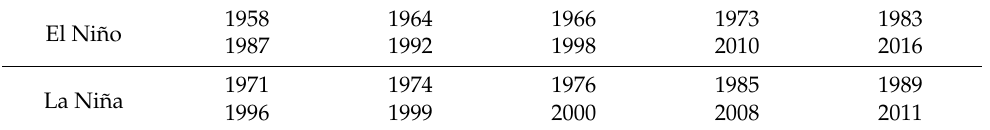
Table 1. List of the El Niño and La Niña decaying years during 1958–2019 used in the composite analysis. El